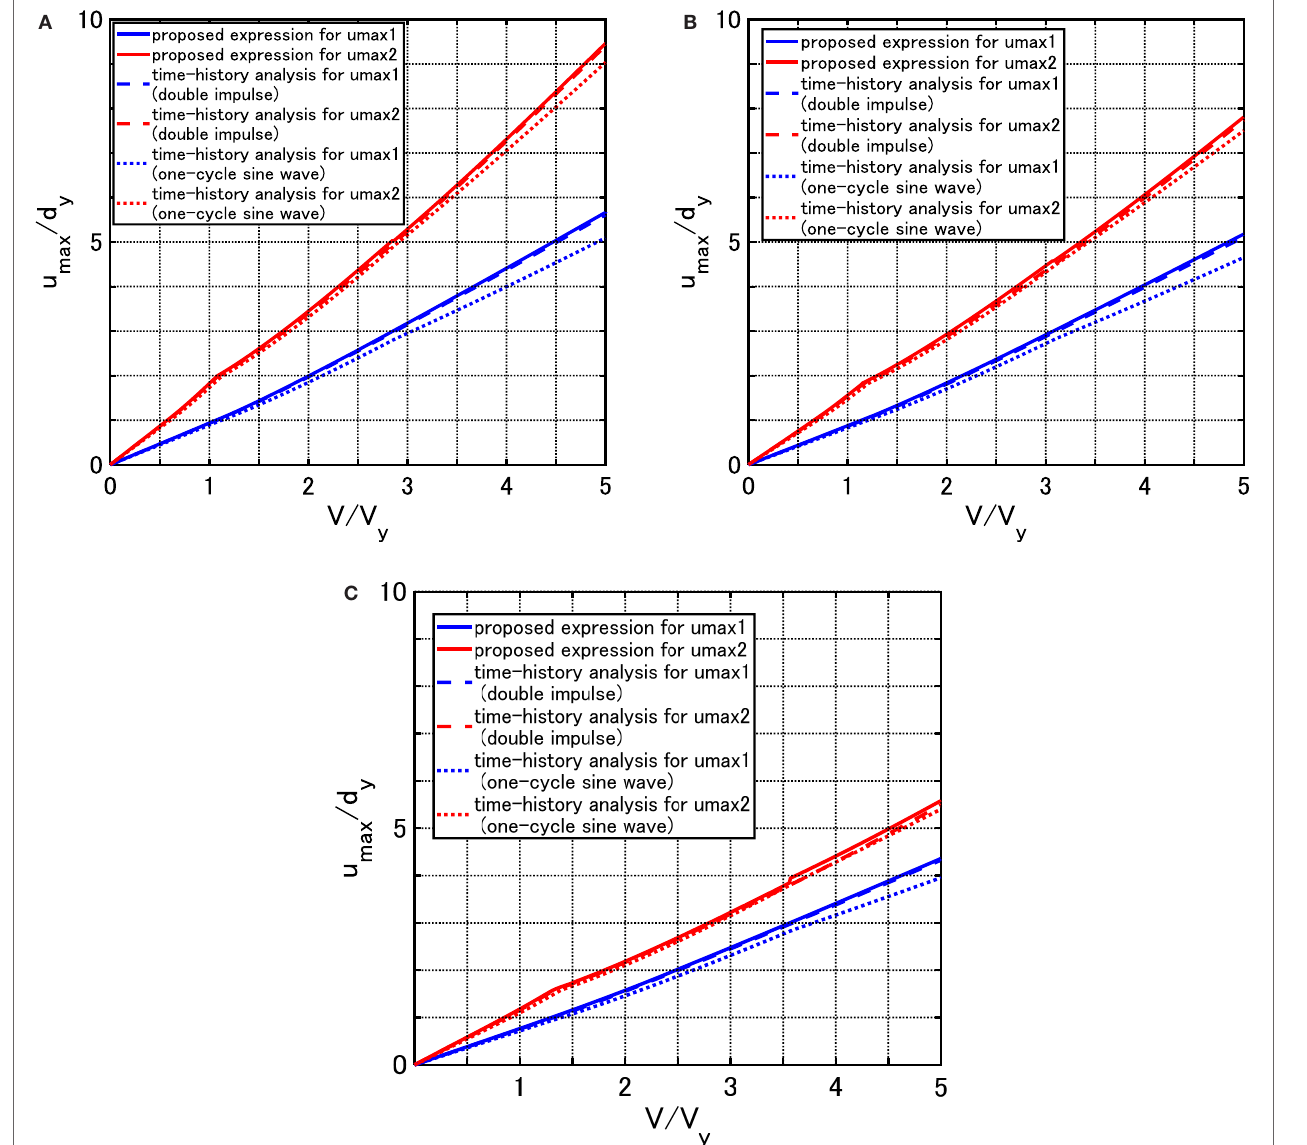
FIGURE 11 | Comparison of maximum deformations for model of α = 0.5 among proposed method, time-history response analysis under double impulse and time-history response analysis under corresponding one-cycle sine wave, (A) h = 0.05, (B) h = 0.1, and (C) h =